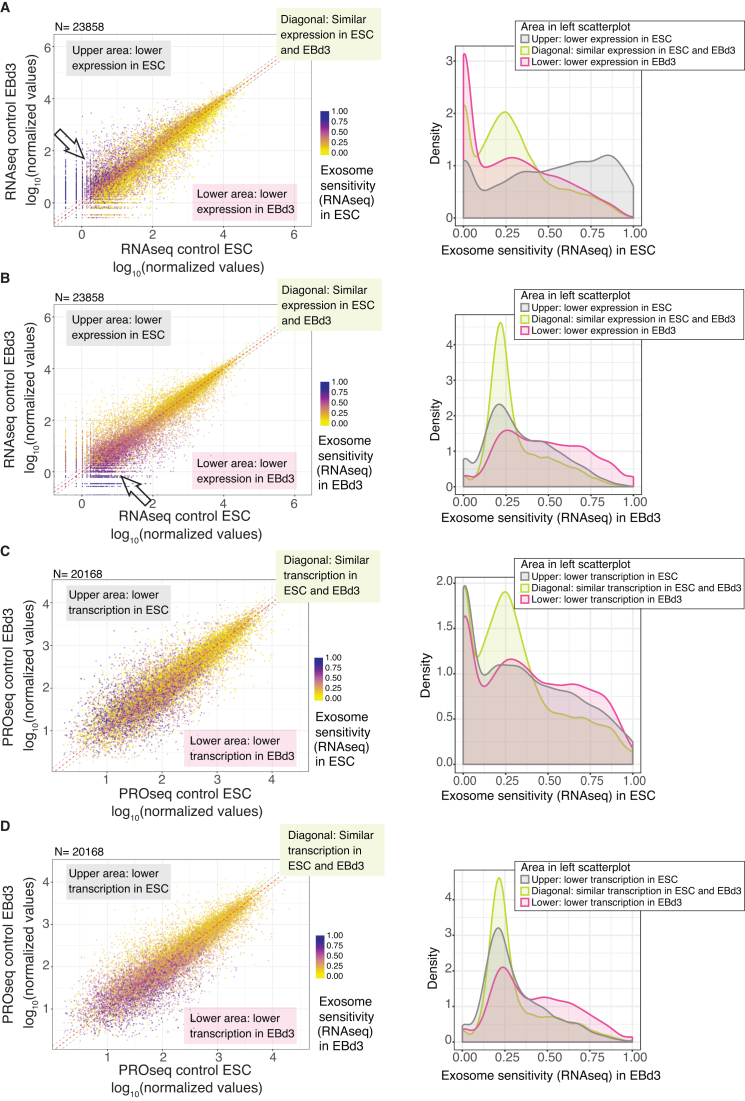
Transcripts tend to be exosome sensitive in the cell state where they are most lowly expressed. (A) Left panel: log10 normalized RNAseq values for RNAs from all GENCODE-annotated genes in control EBd3 (y-axis) and control ESC (x-axis) states, coloured according to their exosome sensitivity in the ESC state as calculated from RNAseq data (as shown on the legend to the right: purple denotes the most exosome-sensitive RNAs). The white arrow emphasizes particularly exosome-sensitive RNAs. The red dashed line marks equal expression levels between EBd3 and ESCs. Based on the red dashed lines, three regions of the plot were defined, indicated by callouts and grey dotted lines, which are further analyzed in the right panel: upper area (region above upper grey line, grey line in the right panel) contains transcripts with lower expression in ESCs; lower area (region below lower grey line, pink line in the right panel) contains transcripts with lower expression in EBd3; diagonal (region between grey lines, green line in the right panel) contains transcripts with similar expression in ESC and EBd3. Right panel: Densities of RRP40 sensitivity in ESCs for transcripts falling into the three areas defined in the left panel. (B) As in A, but with exosome sensitivity calculated from the EBd3 state. (C) As in A, but signals on x- and y-axes in the left panel are based on PROseq data. (D) As in C, but with exosome sensitivity calculated from the EBd3 state. For all plots, the number of genes/RNAs (N) included is indicated above each panel.